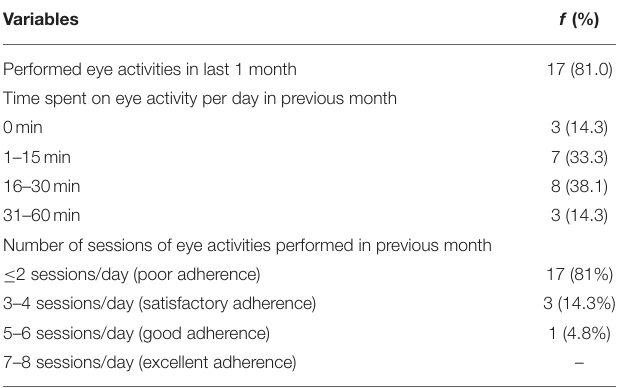
TABLE 3 | Treatment adherence of